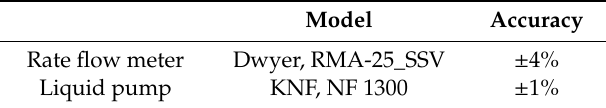
Table 4. Instruments used for the experiment.